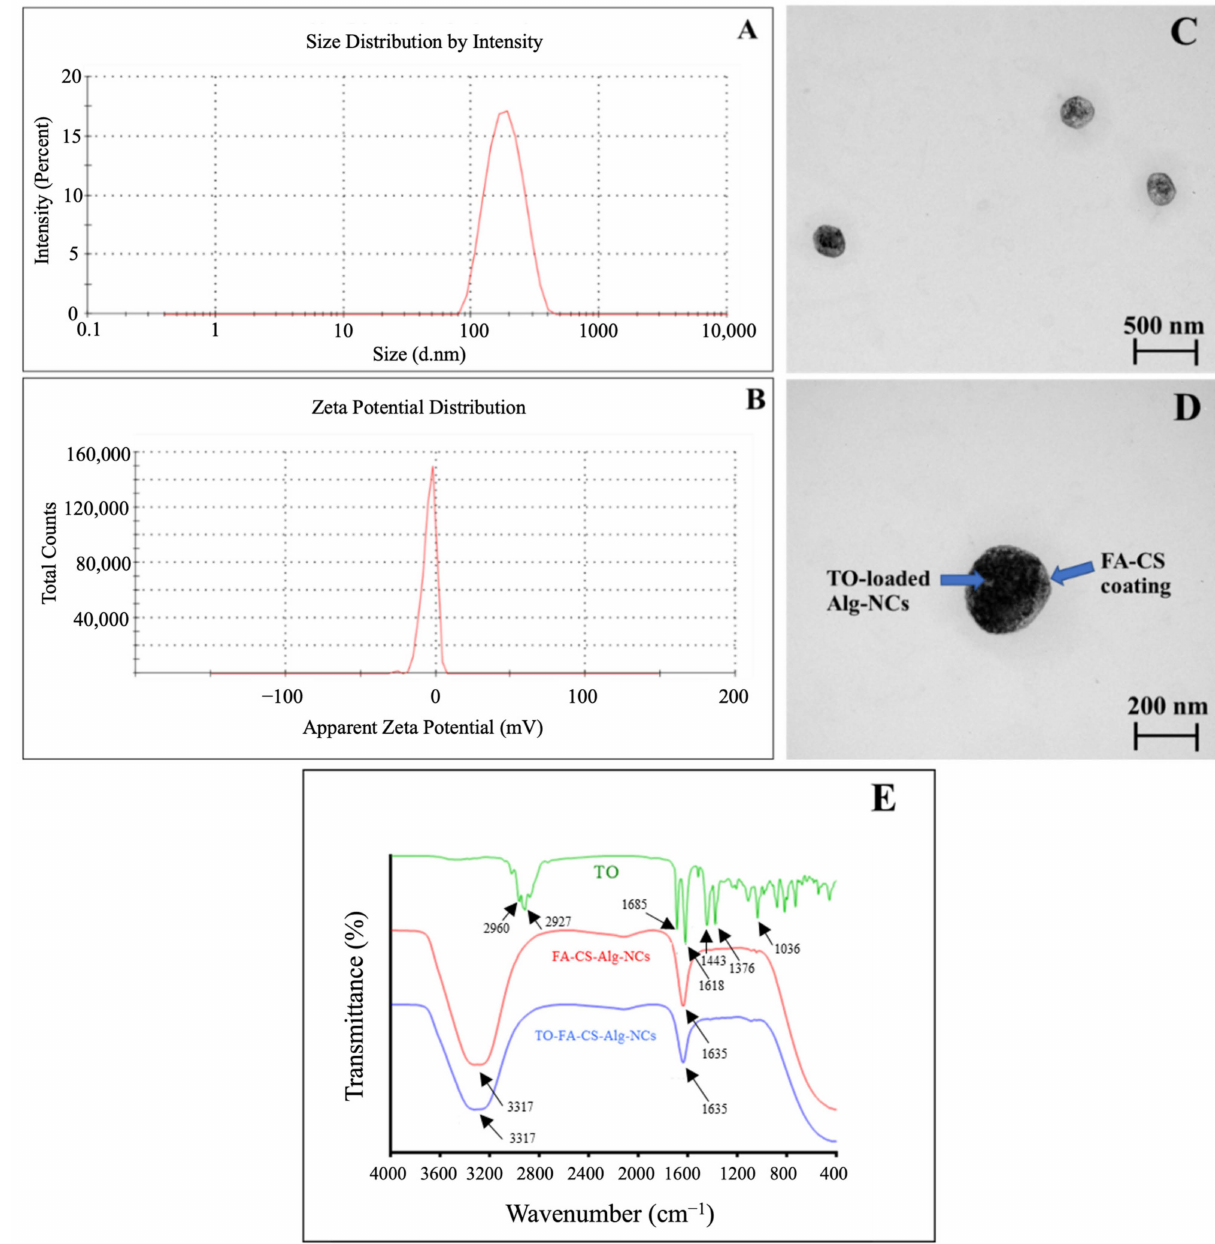
Figure 4. Physico-chemical characteristics of the optimized TO-FA-CS-Alg-NCs: ( A ) Size distribution by intensity; ( B ) Zeta potential distribution; ( C , D ) TEM images at 50,000 and 100,000 × magnification, respectively; ( E ): FT-IR spectra of TO, FA-CS-Alg-NCs and